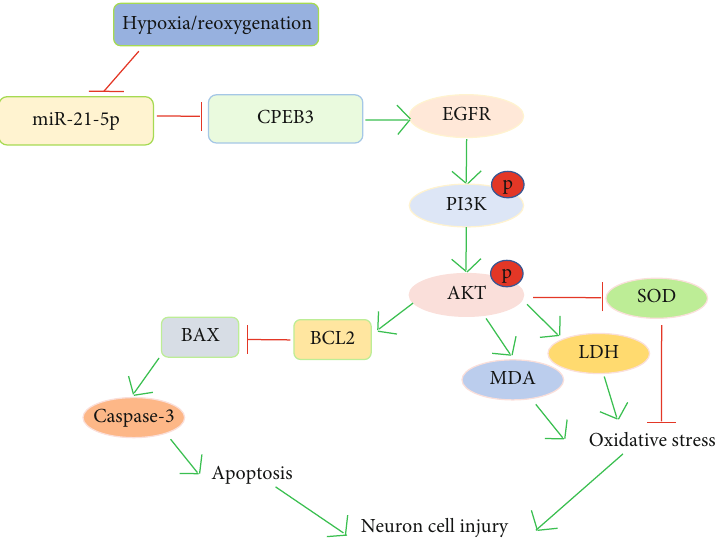
Figure 8: Diagram showing the roles of miR-21-5p/CPEB3 in H/R-induced HT22 cell